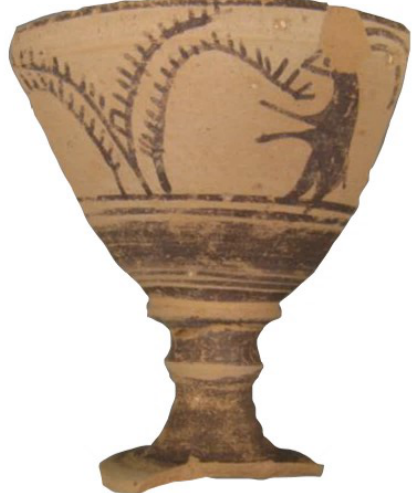
Figure 16. White Painted I stemmed goblet from the sanctuary at Agia Irini, AIS 0400.002, H. 14.5 cm, © Medelhavsmuseet.